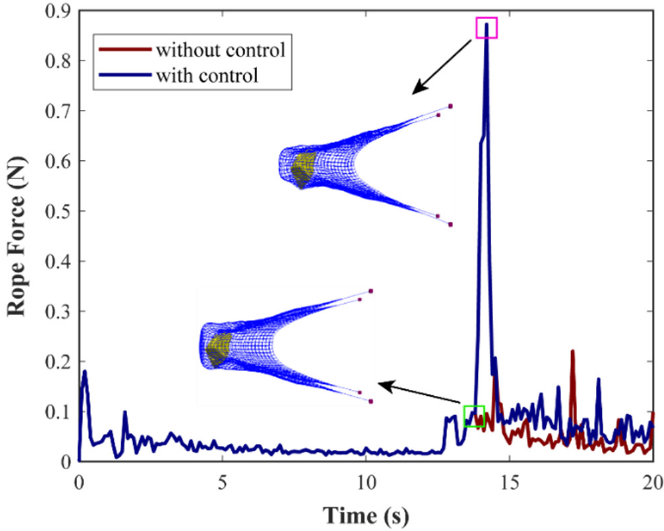
Figure 6. Rope force of the net threads during the capture and control process.